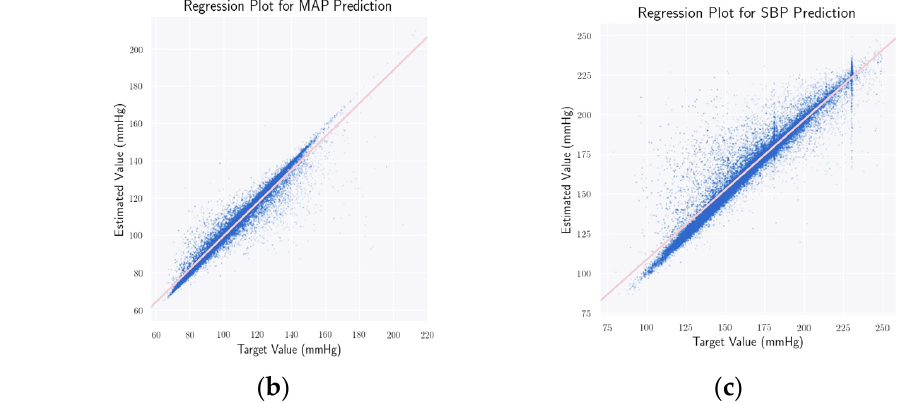
Figure 7. Bland–Altman plot. Here, through the Bland–Altman plots, it is evident that the error of predicting DBP, MAP, and SBP of 95% of the samples lies between [ − 11.825:15.0637] ( a ), [ − 9.095:10.357] ( b ), and [ − 22.531:19.367] ( c ), respectively. In addition, Figure 8 depicts the regression plots for predicting DBP, MAP, and SBP, respectively. From the plots, the correlation between the predictions and the ground truth is evident. Moreover, the values of the Pearson Correlation Coefficient (PCC) for DBP, MAP, and SBP predictions are 0.894, 0.966, and 0.936, respectively, indicating a strong positive correlation. Furthermore, such high values of PCC on a sample size of 27,260 cor- respond to ( p < 0.000001). Stating our null hypothesis to be the lack of any correlation between ground truth and predicted BP values, such a low p -value rejects the null hypoth- esis with a great margin, indicating the statistical significance of our results.